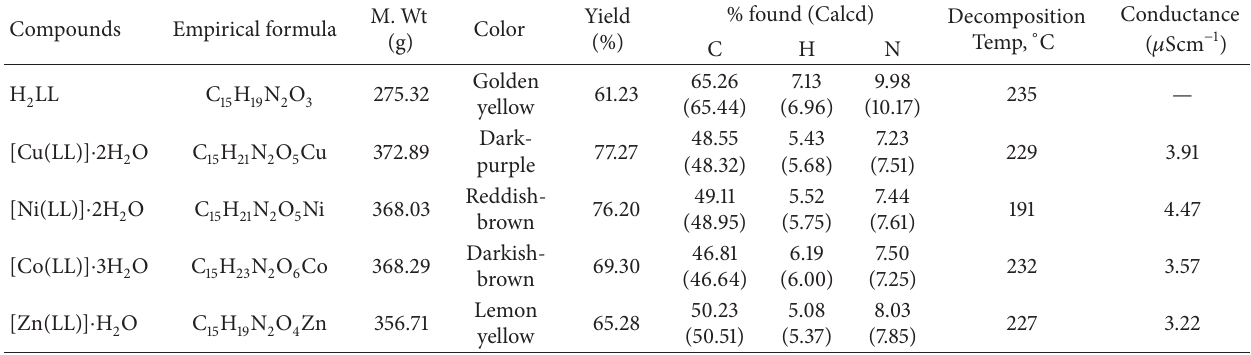
LL ] and its complexes. 2